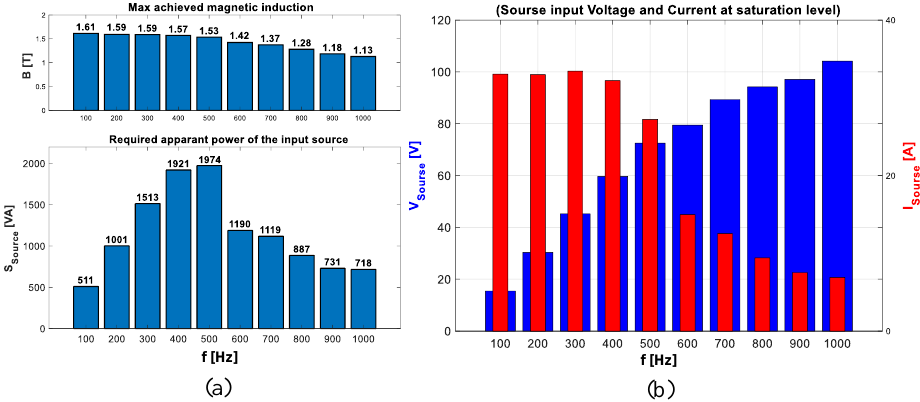
Figure 13. Measured delivered power of the input source at different frequencies. ( a ) Apparent power at the maximum achieved magnetic flux density. ( b ) Voltage and current components.